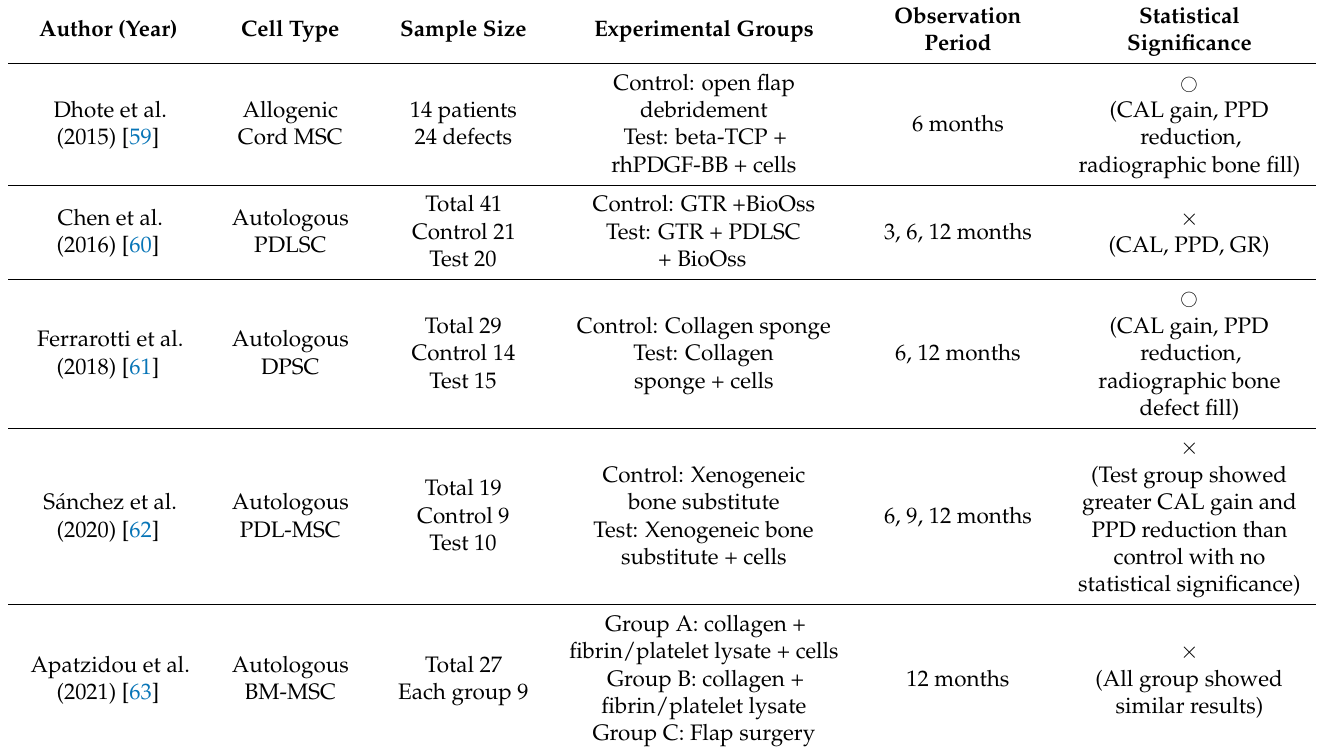
Table 2. Results of human controlled clinical trials for cell-based periodontal regenerative